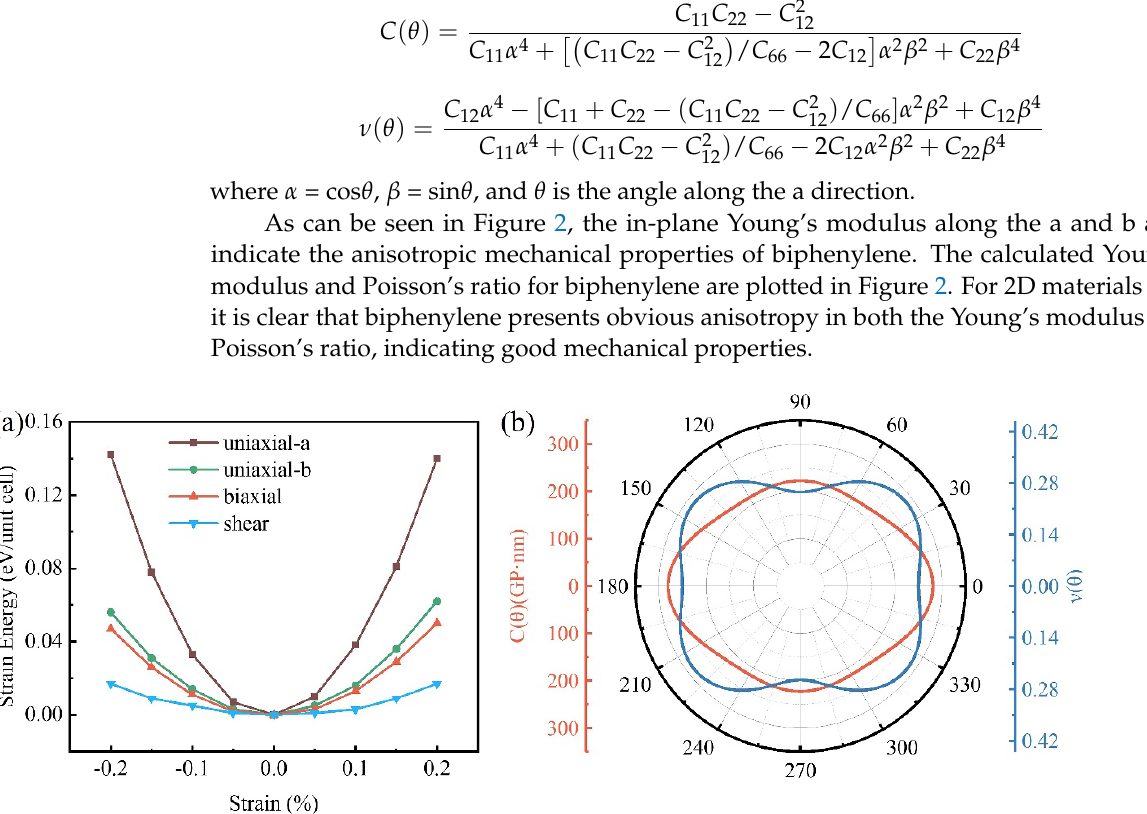
Figure 2. ( a ) Calculated deformation energies as functions of external strains for biphenylene. ( b ) The direction-dependent Young’s modulus C (θ) and Poisson’s ratio v (θ) of biphenylene. direction-dependent Young’s modulus C ( θ ) and Poisson’s ratio v ( θ ) of